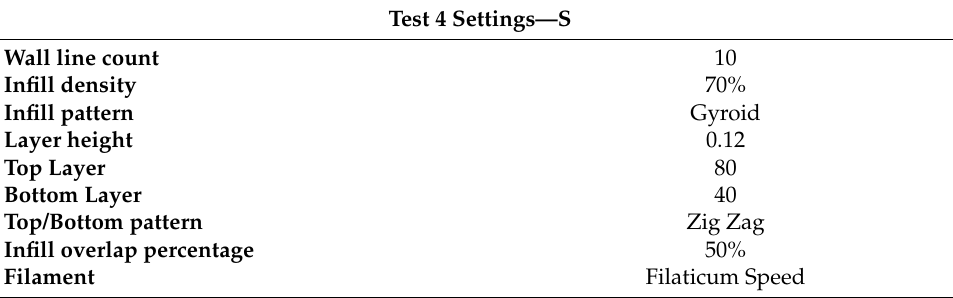
Table 11. Punch settings of Test 4—S.